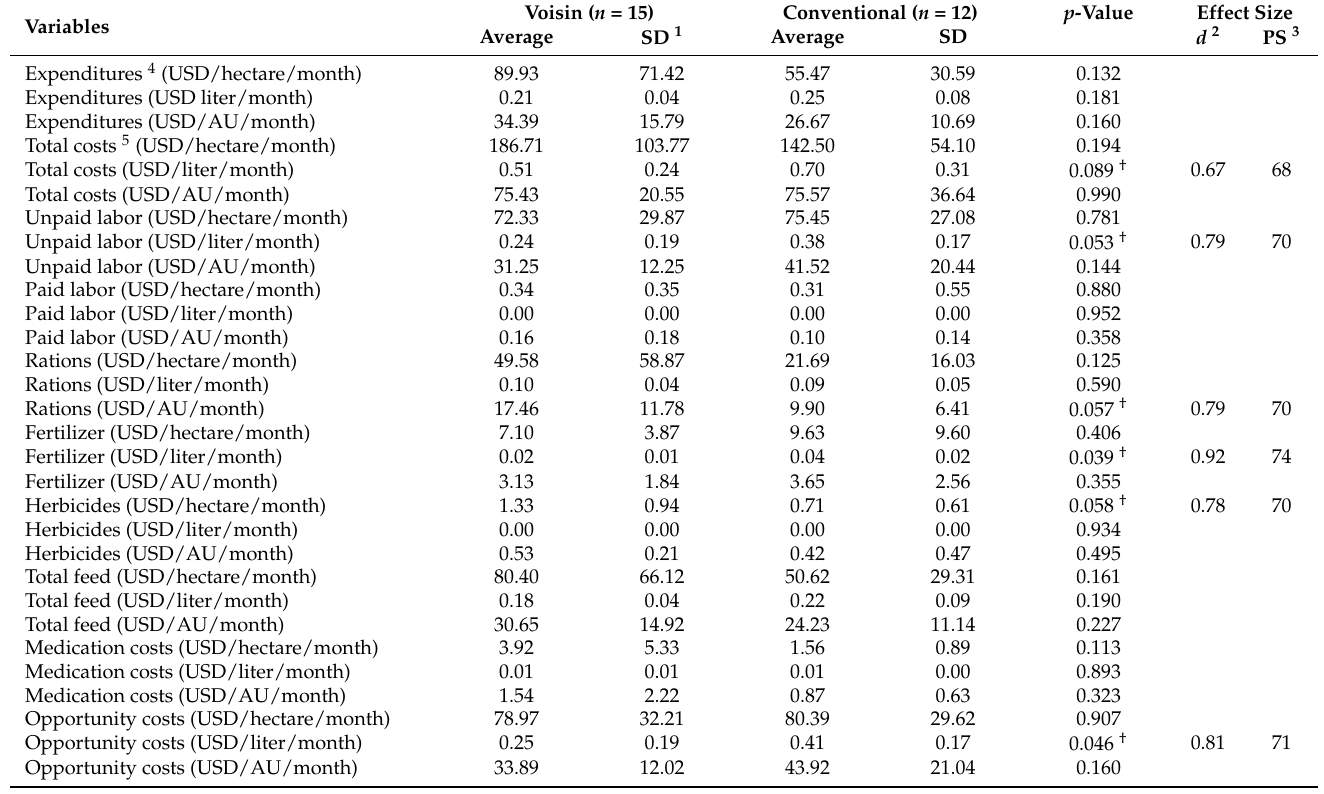
Table 6. Monthly farm inputs divided per hectare, animal unit (AU), and